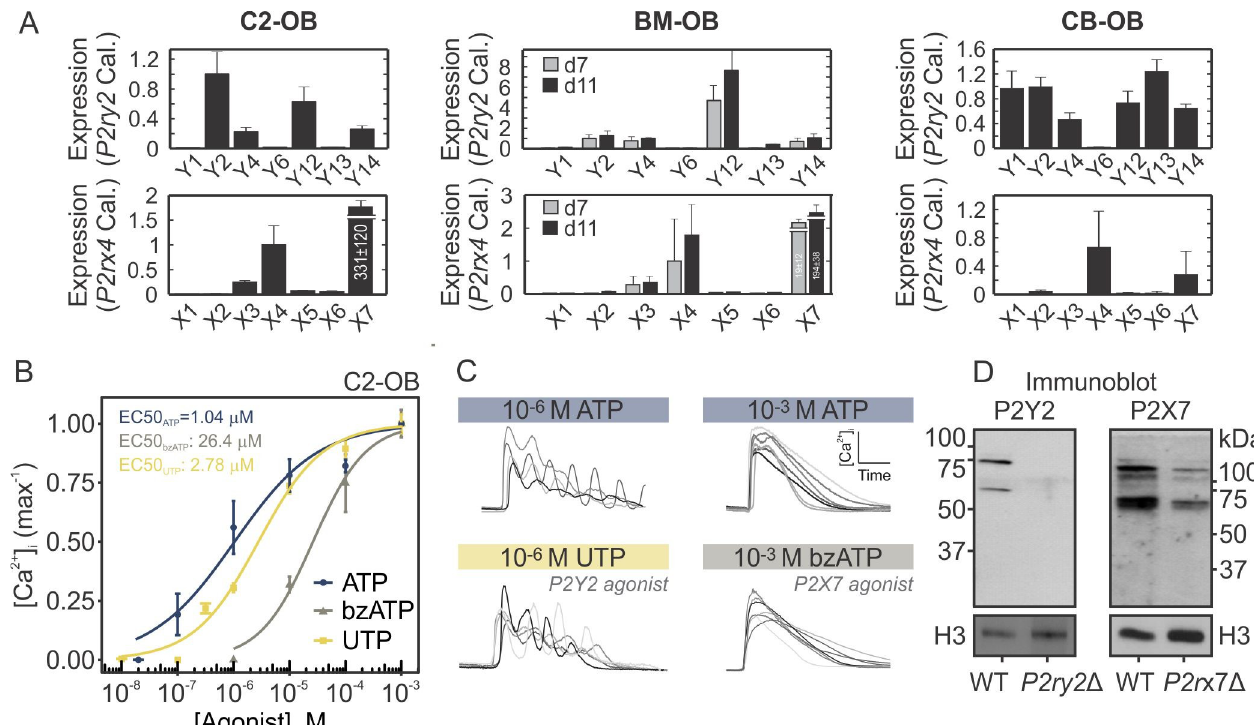
Fig 2. Functional P2Y2 and P2X7 are expressed in osteoblastic cells. ( A ) P2 expression determined by RT-qPCR in C2-OB, BM-OB, and CB-OB. Relative transcript expression was calculated by ΔΔ CT method, and P2ry2 and P2rx4 were used as calibrators for P2Y and P2X receptors, respectively. Data are means ± SEM, n = 3 independent cultures per cell line. (B) Fura2-loaded C2-OB cells were stimulated by ATP, UTP, or BzATP and [Ca 2+ ] i response magnitudes were measured. Data are normalized means ± SEM ( markers ) fitted with hill functions ( curves ) for their dose-response curves. (C) Representative Ca 2+ responses observed in C2-OB stimulated by 10 − 6 M ATP or UTP, and 10 − 3 M ATP or BzATP. ( D ) P2Y2 and P2X7 protein expression assessed by immunoblot in WT, P2ry2 Δ and P2rx7 Δ C2-OB whole cell lysates. Histone H3 was used as a loading control.